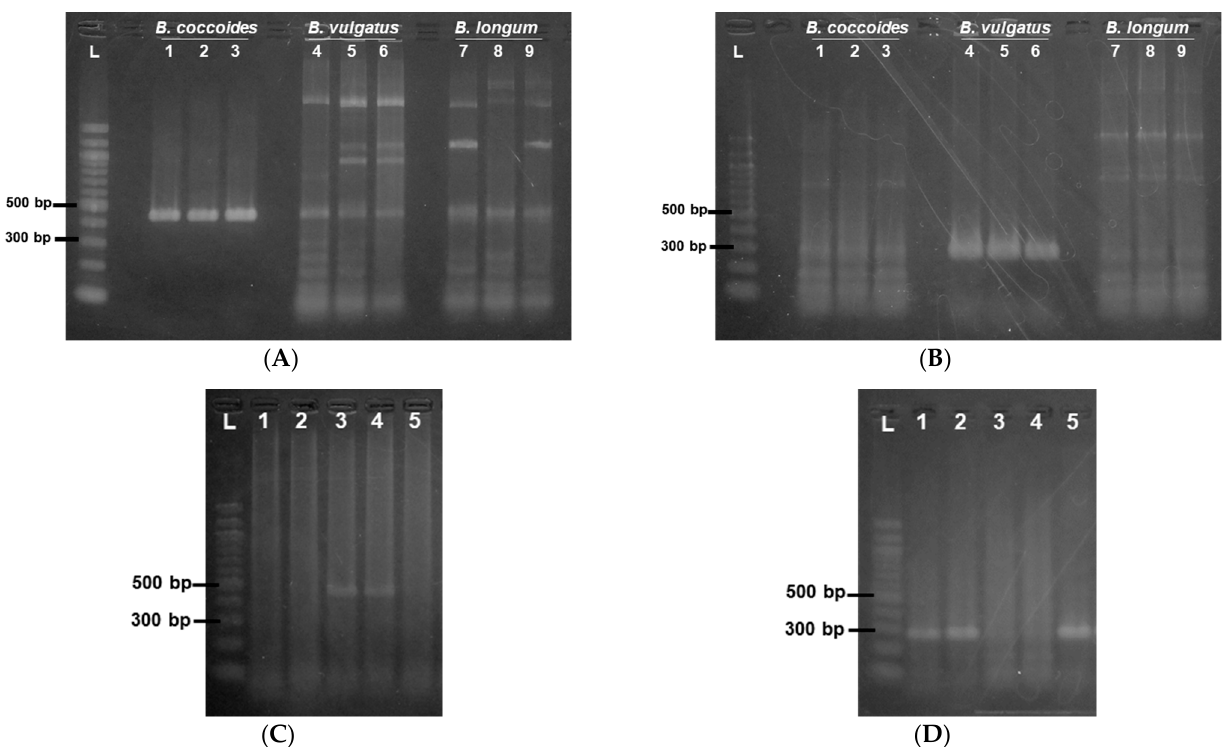
Figure 2. Identification of B. coccoides JCM1395 T and B. vulgatus JCM5826 T by colony PCR. SYBR ® GREEN stained agarose gel electrophoresis images applied with 16S rRNA gene PCR amplicons by primers corresponding to ( A ) B. coccoides JCM1395 T and ( B ) B. vulgatus JCM5826 T . The PCR amplicons from B. coccoides JCM1395 T , B. vulgatus JCM5826 T , and B. longum JCM1217 T colonies were applied to lanes 1–3, lanes 4–6, and lanes 7–9, respectively. ( C , D ) Detection of B. coccoides JCM1395 T and B. vulgatus JCM5826 T from tumor homogenates by colony PCR. The experiments were performed on three mice, respectively, of which typical gel images are shown. SYBR ® GREEN stained agarose gel electrophoresis images applied with 16S rRNA gene PCR amplicons of 5 colonies picked from the agar plate seeded with tumor homogenate by primers corresponding to ( C ) B. coccoides JCM1395 T and ( D ) B. vulgatus JCM5826 T . Tumors were isolated from colon-26 tumor-bearing mice a week after receiving the bacterial mixture of B. coccoides JCM1395 T (3.7 × 10 7 CFU/mouse) and B. vulgatus JCM5826 T (5.4 × 10 7 CFU/mouse). The number in the fi gure indicates each colony.